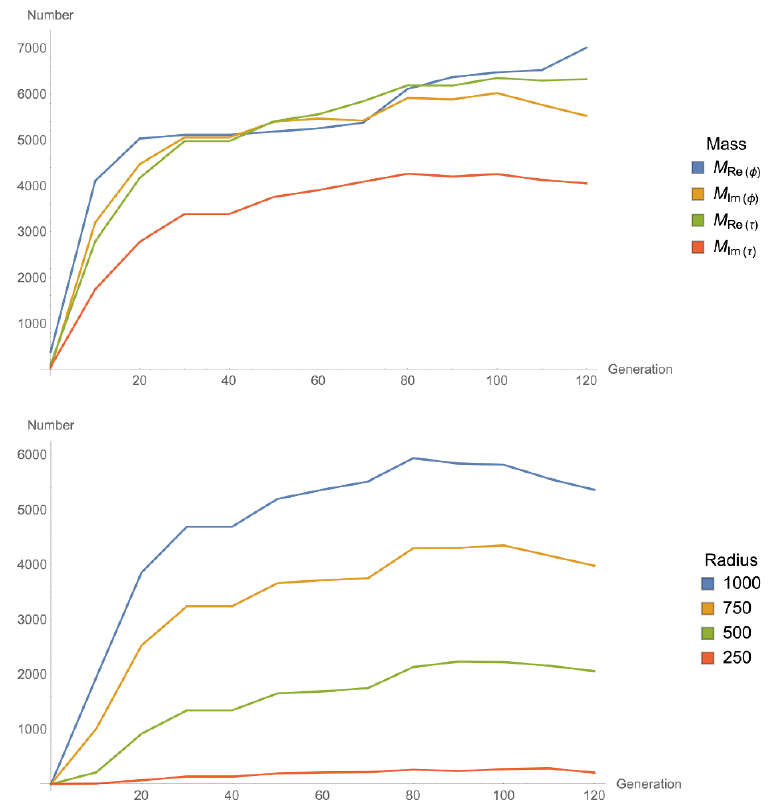
Figure 16 . Top: the number of individuals having a single mass matrix entry within a neighbor- hood of r = 500. Bottom: the number of individuals having all four masses within neighborhoods of di(cid:11)erent